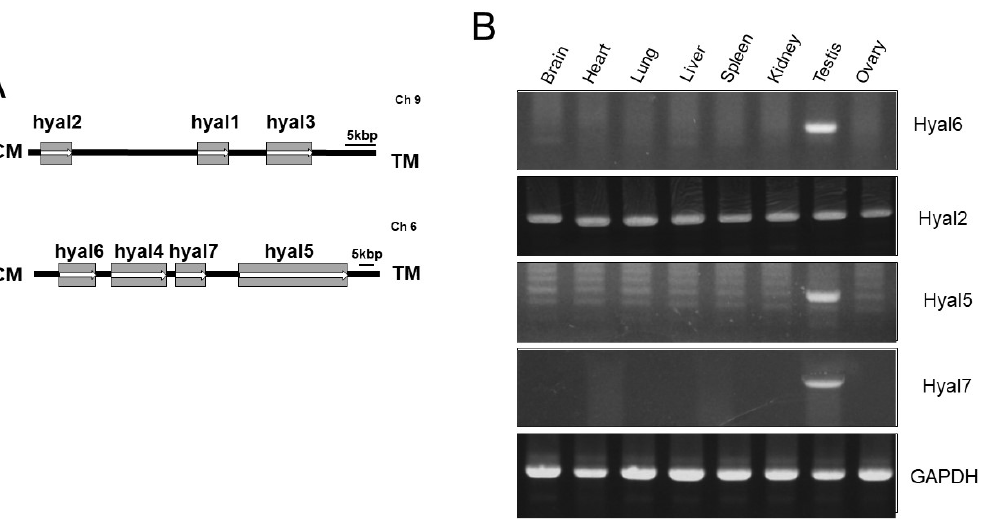
Figure 1. Chromosomal orientation and expression patterns of mouse hyaluronidase ( HYAL ) genes. ( A ) Seven genes ( HYAL1 through HYAL7 ) are located on chromosomes six and nine. Arrows ( → ) indicate the protein-coding direction. TM, telomere; CM, centromere. ( B ) Reverse transcription- polymerase chain reaction (RT-PCR) analysis. Mouse tissue complementary DNA was amplified by PCR, and the fragments were then stained with ethidium bromide. GAPDH; glycer-aldehyde-6- phosphate